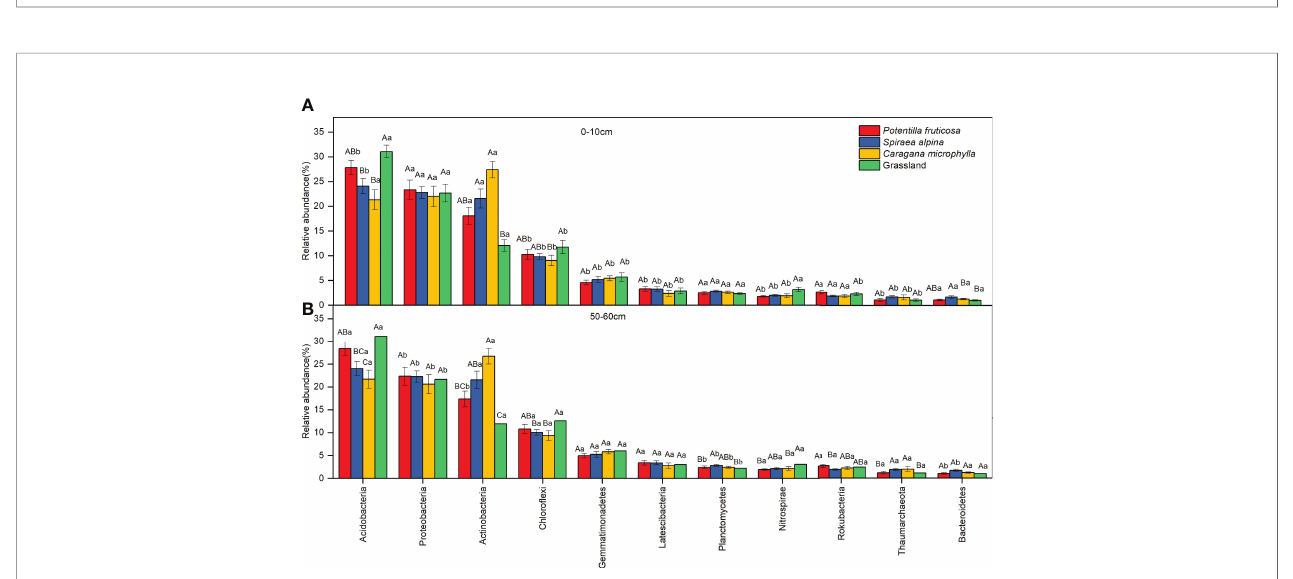
FIGURE 5 | The relative abundance of soil microbial communities at phylum taxonomic level. (A) Surface layer; (B) Deep layer. Bars represent mean; error bars denote standard error. Different lowercase letters indicate signi fi cant differences between the different soil layers within the same vegetation types ( p < 0.05, independent-samples t-test). Different uppercase letters indicate signi fi cant differences between the different vegetation types within the same soil layers ( p < 0.05, Tukey ’ s HSD